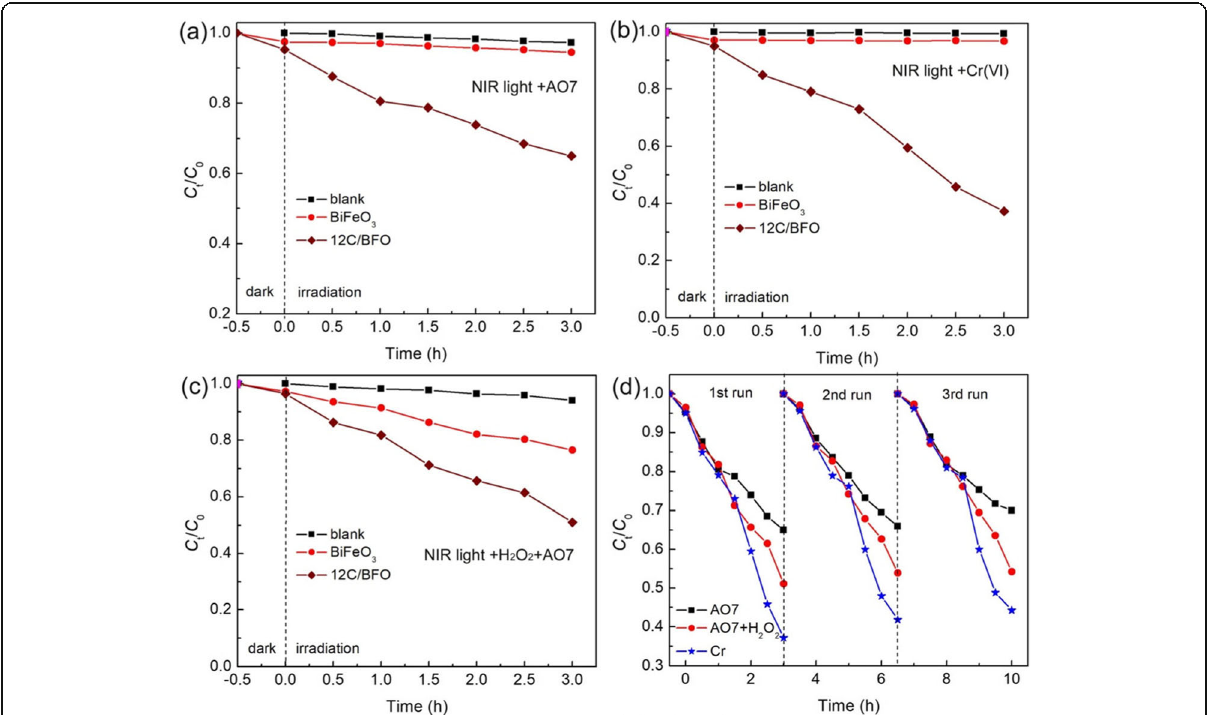
Fig. 9 a Photocatalytic degradation of AO7, b photocatalytic reduction of Cr(VI), and c photo-Fenton catalytic degradation of AO7 over BiFeO 3 and CQD/BiFeO 3 composites under NIR light irradiation. d Recyclability of the 12C/BFO composite for photocatalytic degradation of AO7, photocatalytic reduction of Cr(VI), and photo-Fenton catalytic degradation of AO7 under NIR light